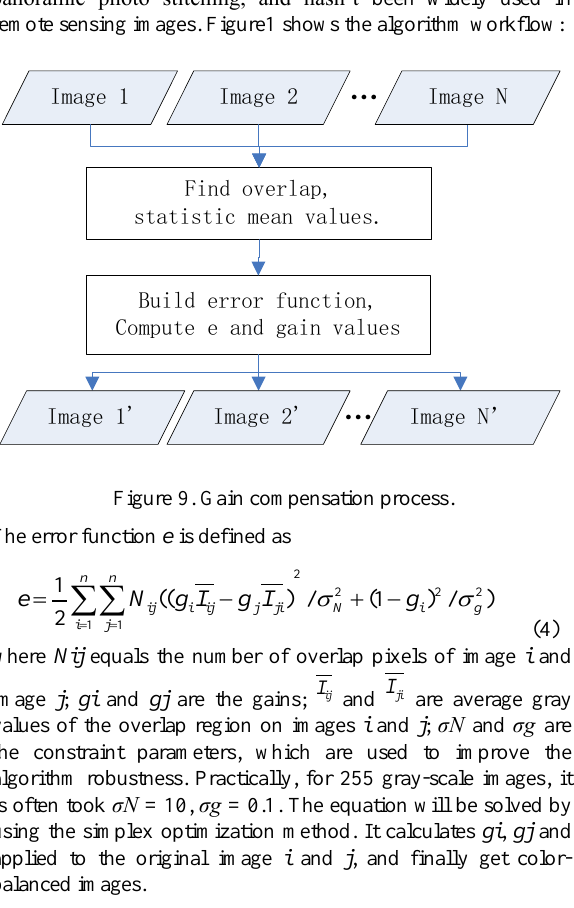
Figure 10. The Edge-center color balancing